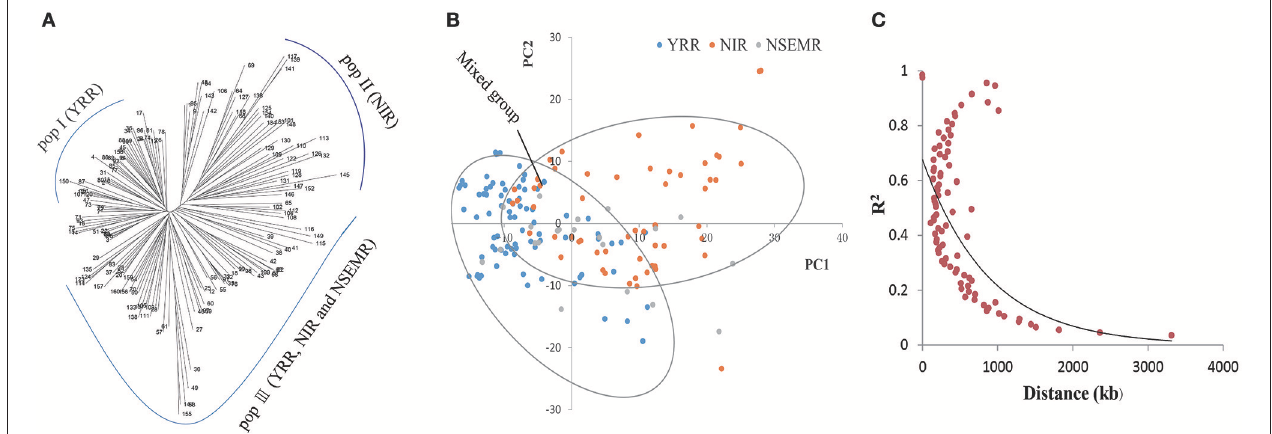
FIGURE 2 | Phylogenetic tree, population structure and LD decay of 160 early-maturity upland cotton accessions. (A) Neighbor-joining phylogenetic tree of all cotton accessions. The pop III was a mixed group including YRR, NIR and NSEMR. (B) Principal component analysis (PCA) of the association panel. (C) The entire genome LD decay of the